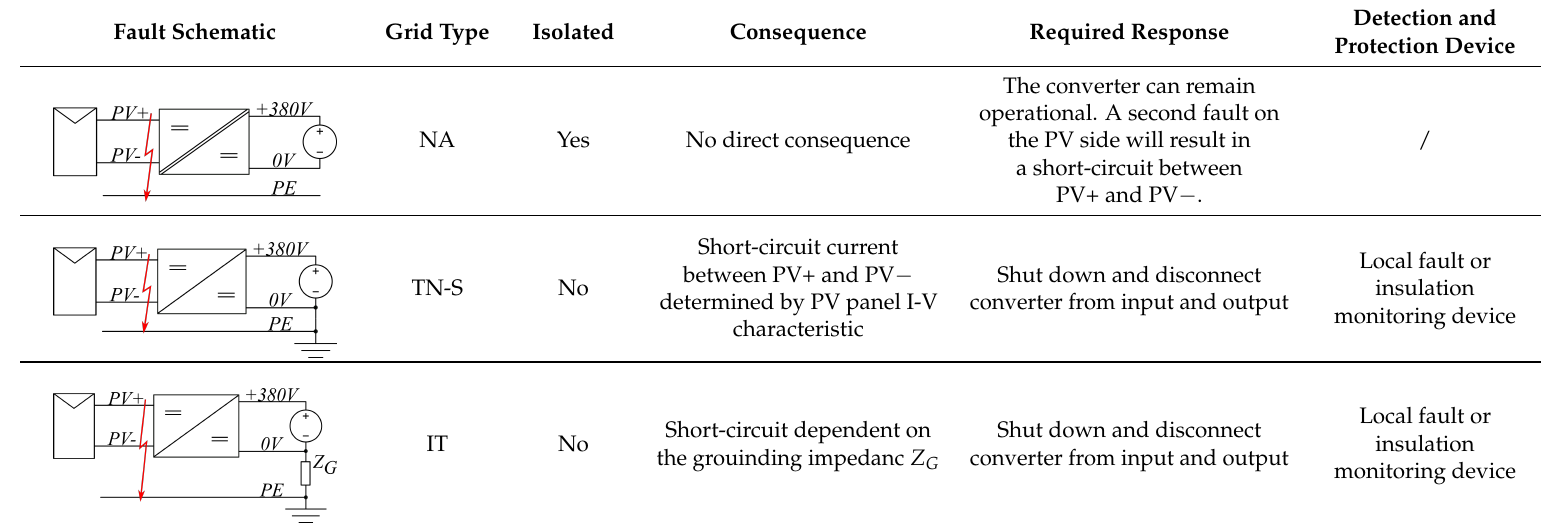
Table 2. An overview on the converter PV side earth faults for different grid configurations and distinguishing galvanic